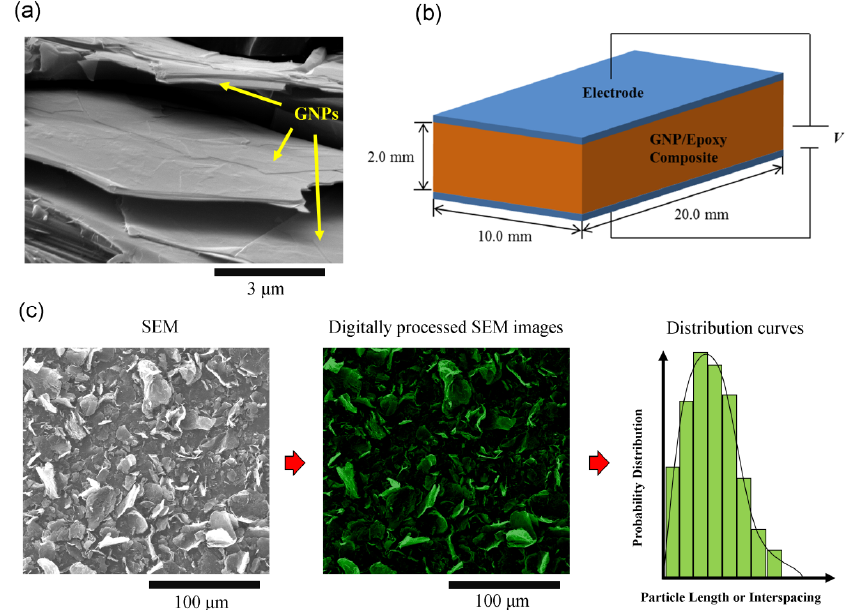
Figure 1. ( a ) Scanning electron microscope (SEM) image of graphene nanoplatelet (GNP)